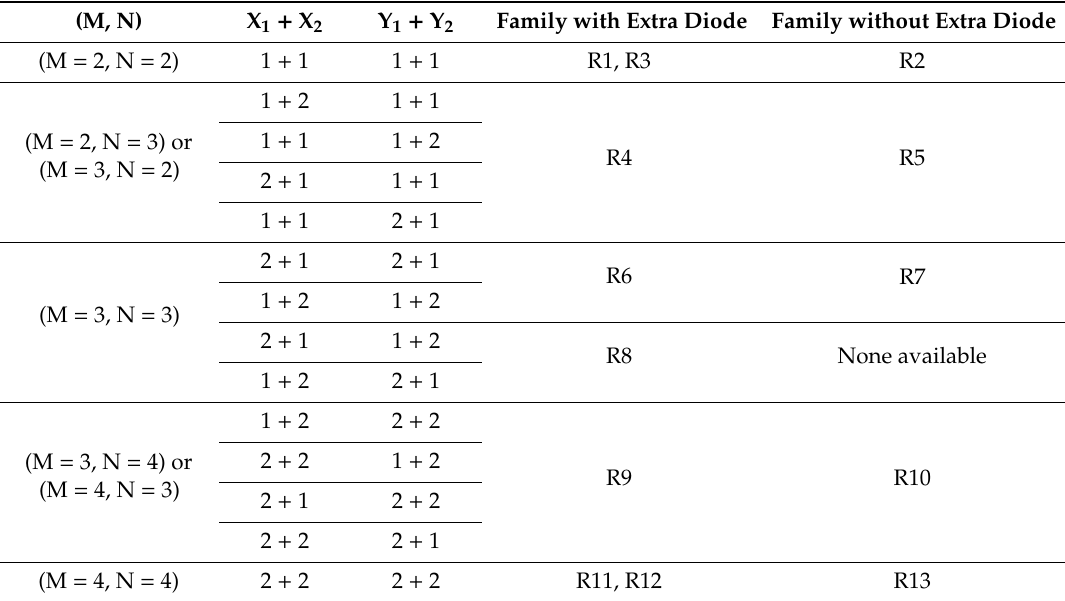
Table 6. Two simplified topological families from MN